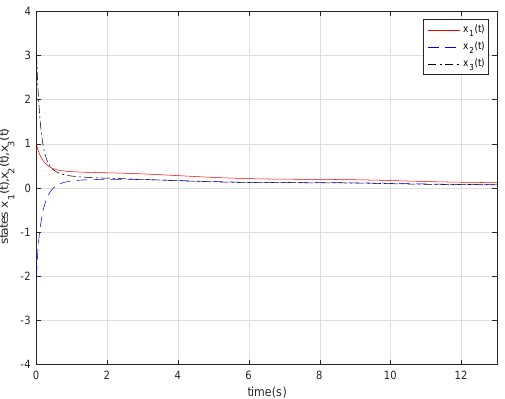
Figure 4. Time response of the selected systems with control input in the Example